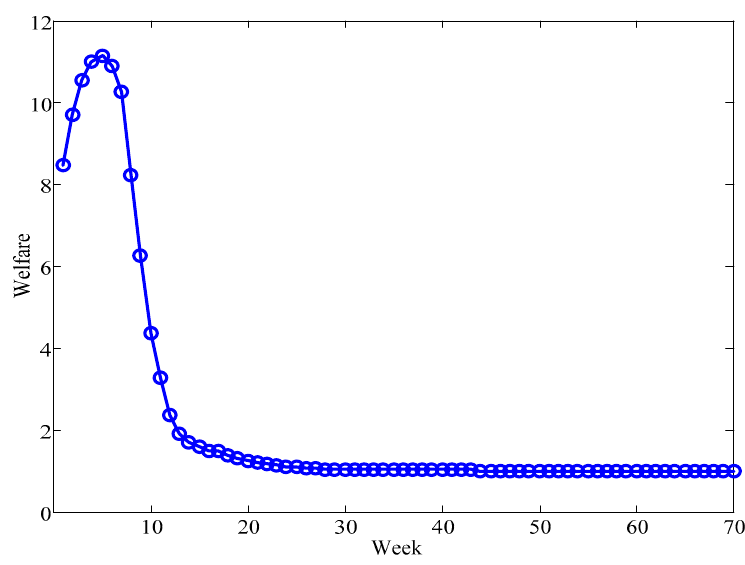
Figure 4. Convergence process of total bidding amount in group N. 417